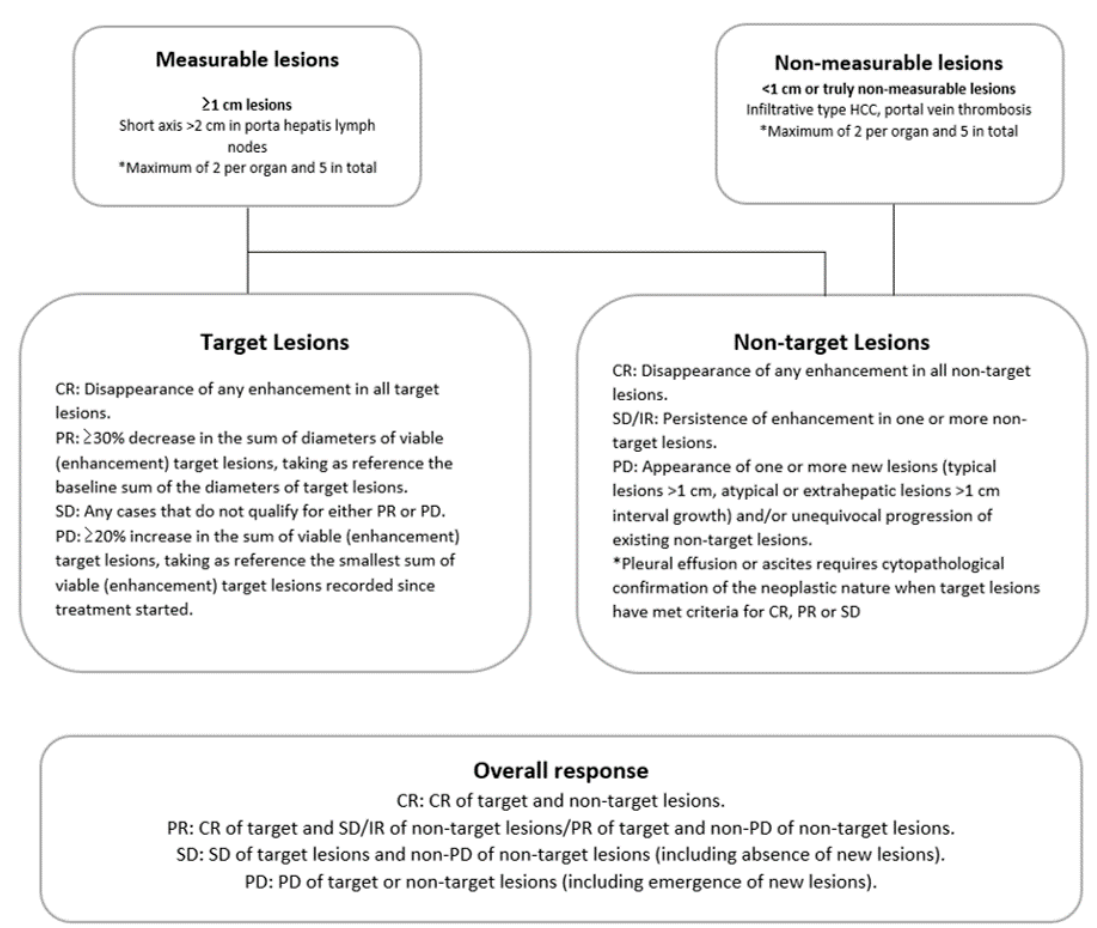
Figure 1. Response evaluation in hepatocellular carcinoma (HCC) by the modified Response Evaluation Criteria in Solid Tumors (mRECIST) guidelines (adapted from [22]).